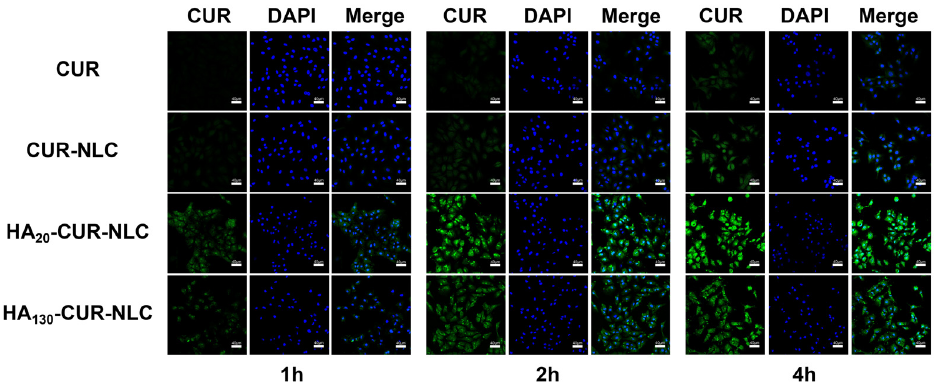
Figure 13. CLSM images of A549 cells after incubating with CUR, CUR-NLC, HA 20 -CUR-NLC, and HA 130 -CUR-NLC for 1, 2, and 4